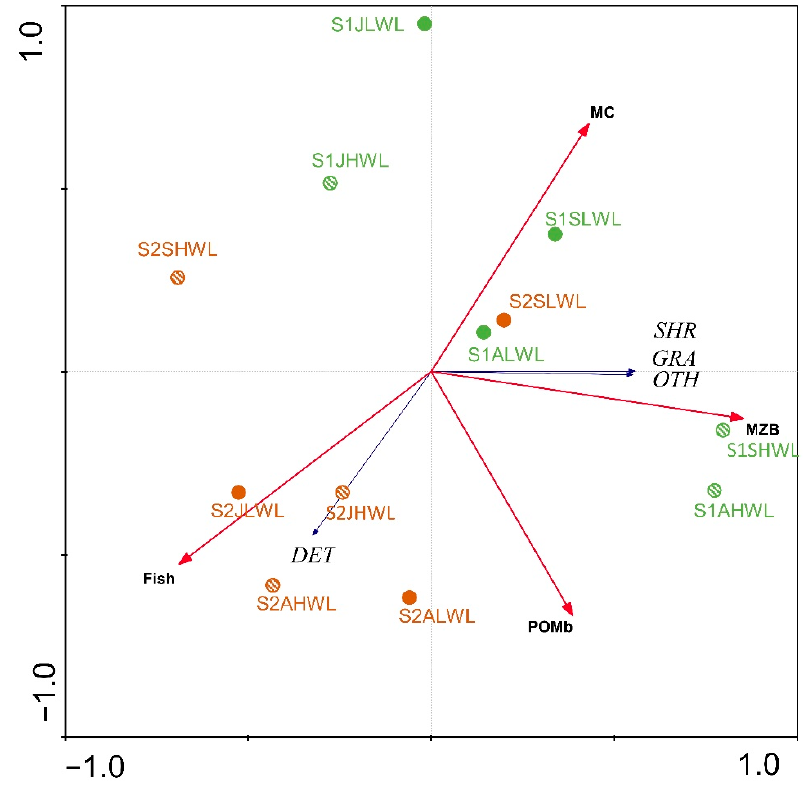
Figure 9. RDA-plot illustrating relationships among sampling sites, physicochemical variables, and functional feeding guilds of gastropods in the littoral benthal area of S1 and S2. Abbreviations are provided in Materials and Methods.